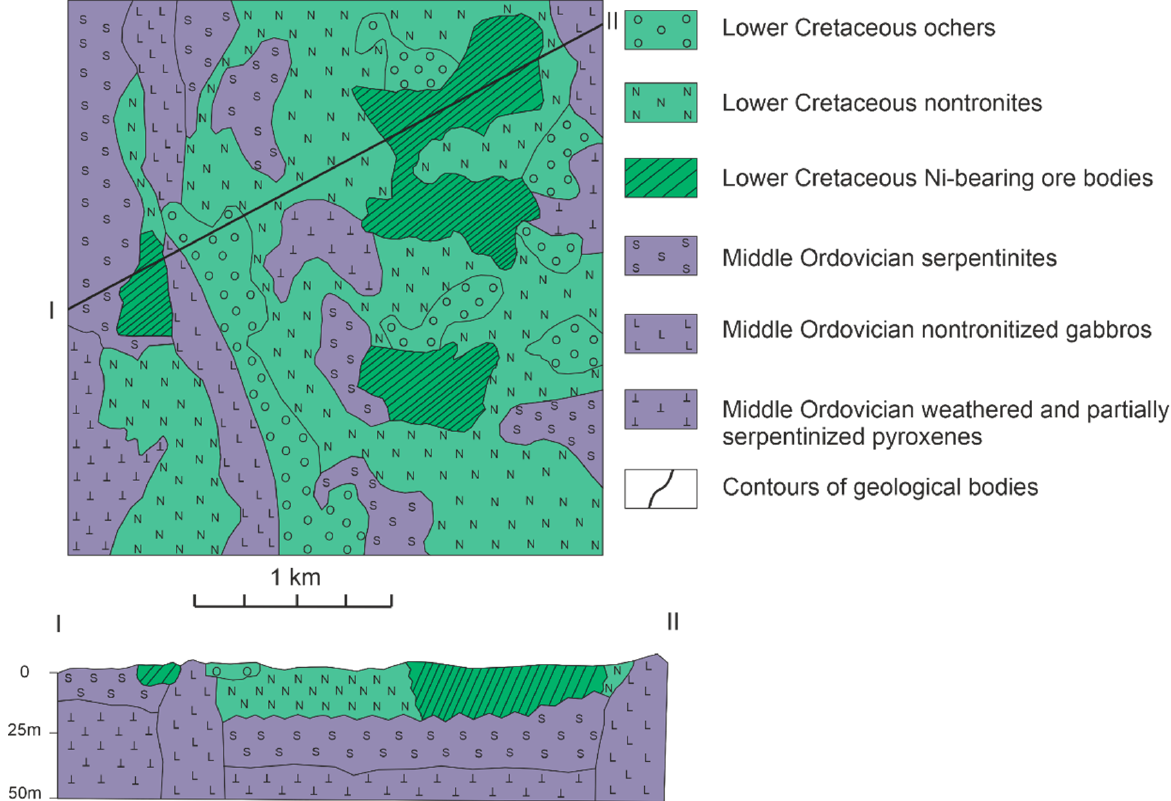
Figure 2. Diagram of the geological structure of the Buranovskoye deposit. Upper (hypergenic) stage—weathering crust. Lower stage—altered ultramafic rocks.